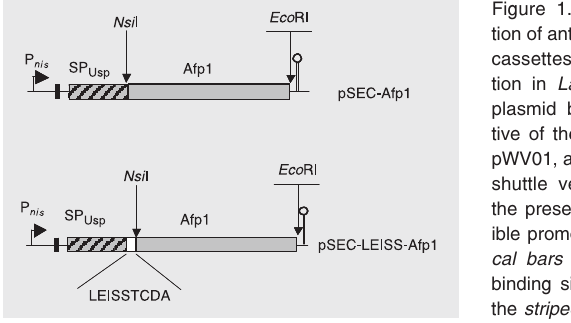
Figure 1. Schematic presenta- tion of antifungal protein 1 (Afp1) cassettes for controlled secre- tion in Lactococcus lactis. The plasmid backbone is a deriva- tive of the rolling circle plasmid pWV01, an E. coli Gram-positive shuttle vector. Arrows indicate the presence of the nisin-induc- ible promoter (P nisA ); solid verti- cal bars indicate the ribosome binding site of the usp45 gene; the striped bar indicates the sig- nal peptide of the usp45 gene